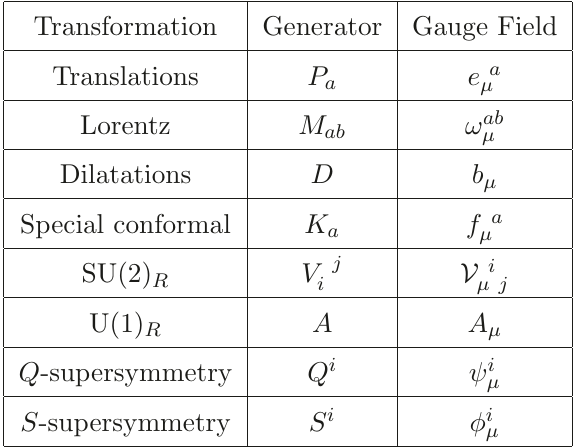
Table 3 . = 2 superconformal symmetries and their corresponding generators in the N superconformal algebra, as well as the gauge fields associated with each